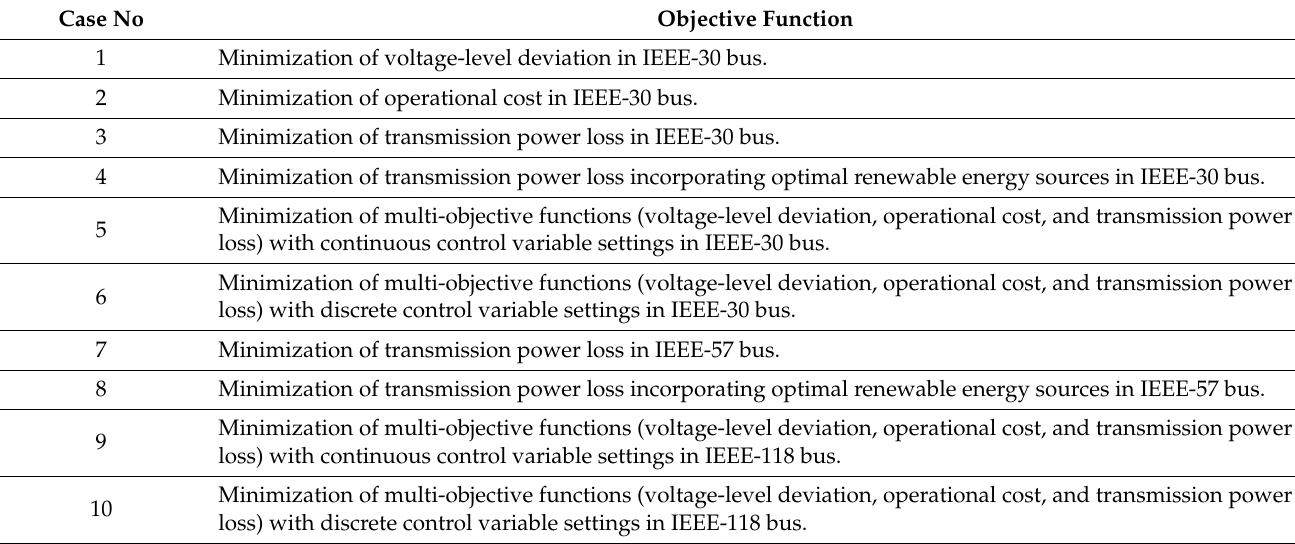
Table 3. Case studies for different objective functions of ORPD